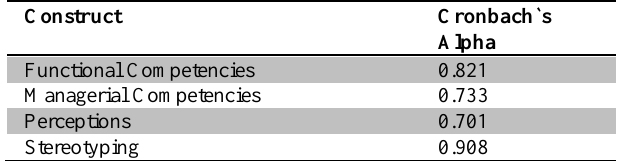
Table 1: Reliability of constructs